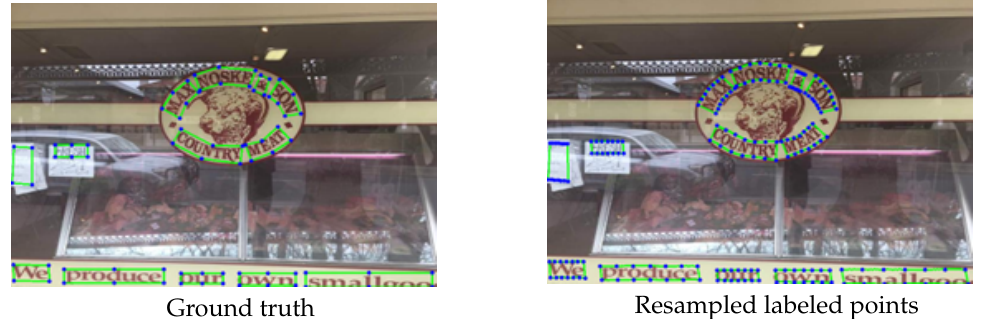
Figure 2. The ground truth and resampled annotation